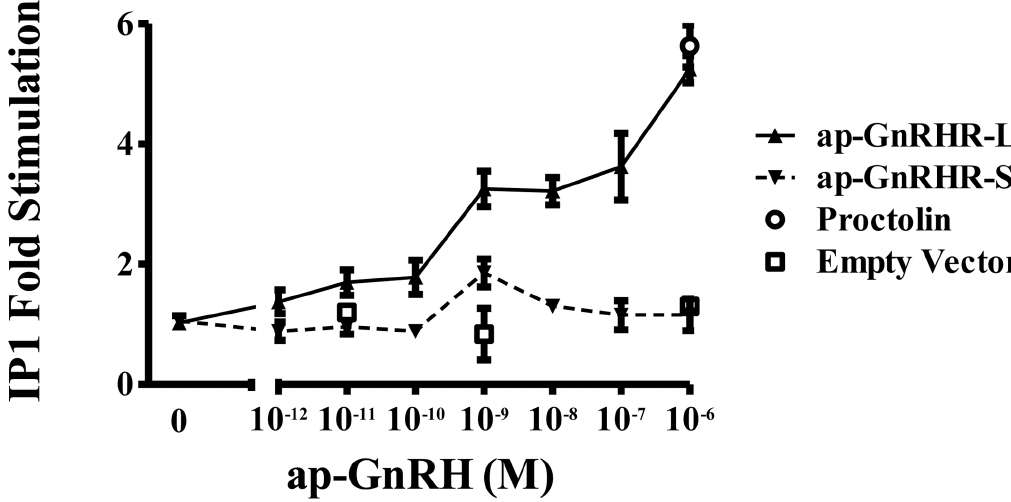
Fig 8. ap-GnRH stimulated IP1 accumulation in S2 cells transfected with ap-GnRHR-L, but not ap-GnRHR-S. Data are expressed as fold stimulation over IP1 levels in the untreated cells. Proctolin was used as a positive control in ap-GnRHR-L or ap-GnRHR-S-transfected cells, and empty vector-transfected cells were used as a negative control. N = 3 assays run in